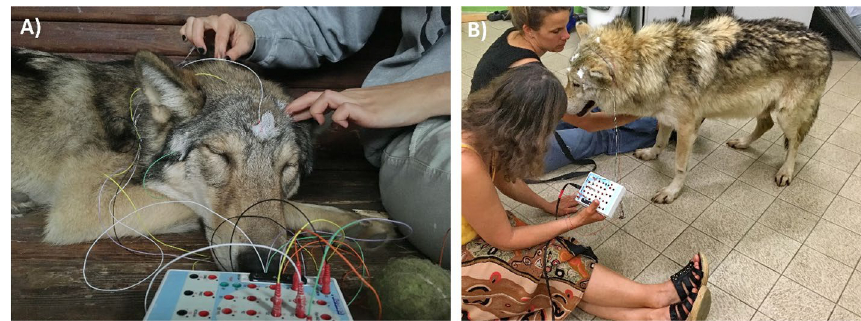
Figure 1. Photo of ( A ) a sleeping young wolf during electrode placement and ( B ) the Senior wolf in the lab at the Department of Ethology after electrode placement, waiting for him to lay